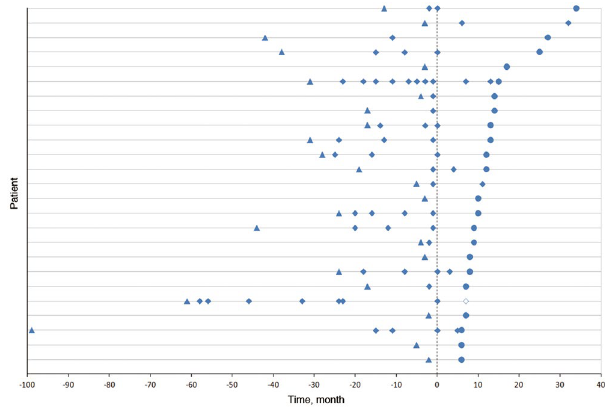
Figure 1. Relapses in Patients With Neuromyelitis Optica Spectrum Disorder (NMOSD) Before and After Tacrolimus Treatment. Figure dipicts relapses before and after treatment with tacrolimus in 25 NMOSD patients, showing a significant reduction in relapse rate (86.2%), with only 1 death. Each row of symbols on the y-axis represents a patient. All the patients were prescribed tacrolimus at time 0. First attack. Relapses. Last follow-up.